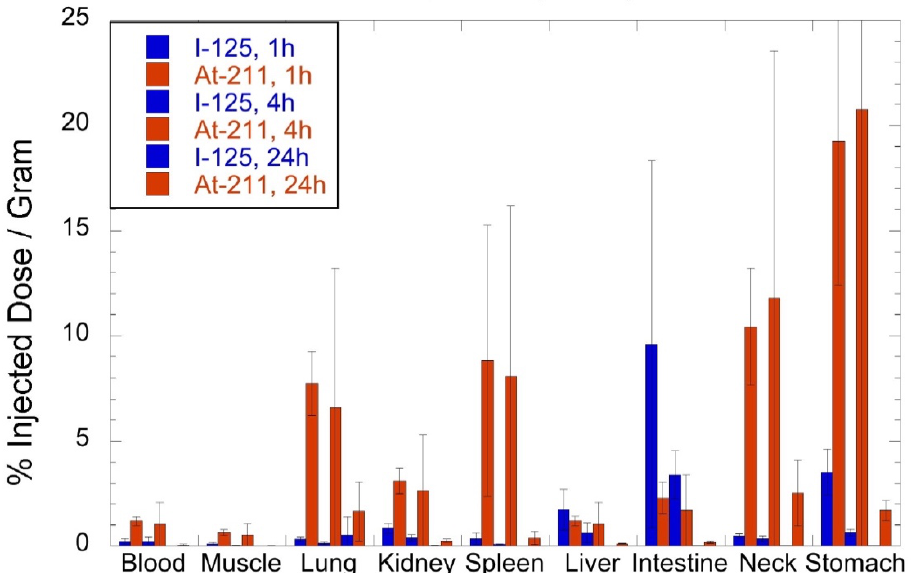
Figure 5. Graph showing %ID/g of isolated products for [ 125 I] 11 and [ 211 At] 13 at 1, 4 and 24 h p.i. in athymic mice. (n = 5) See Table S1 in Supplementary Materials for a tabulation of %ID/g data.